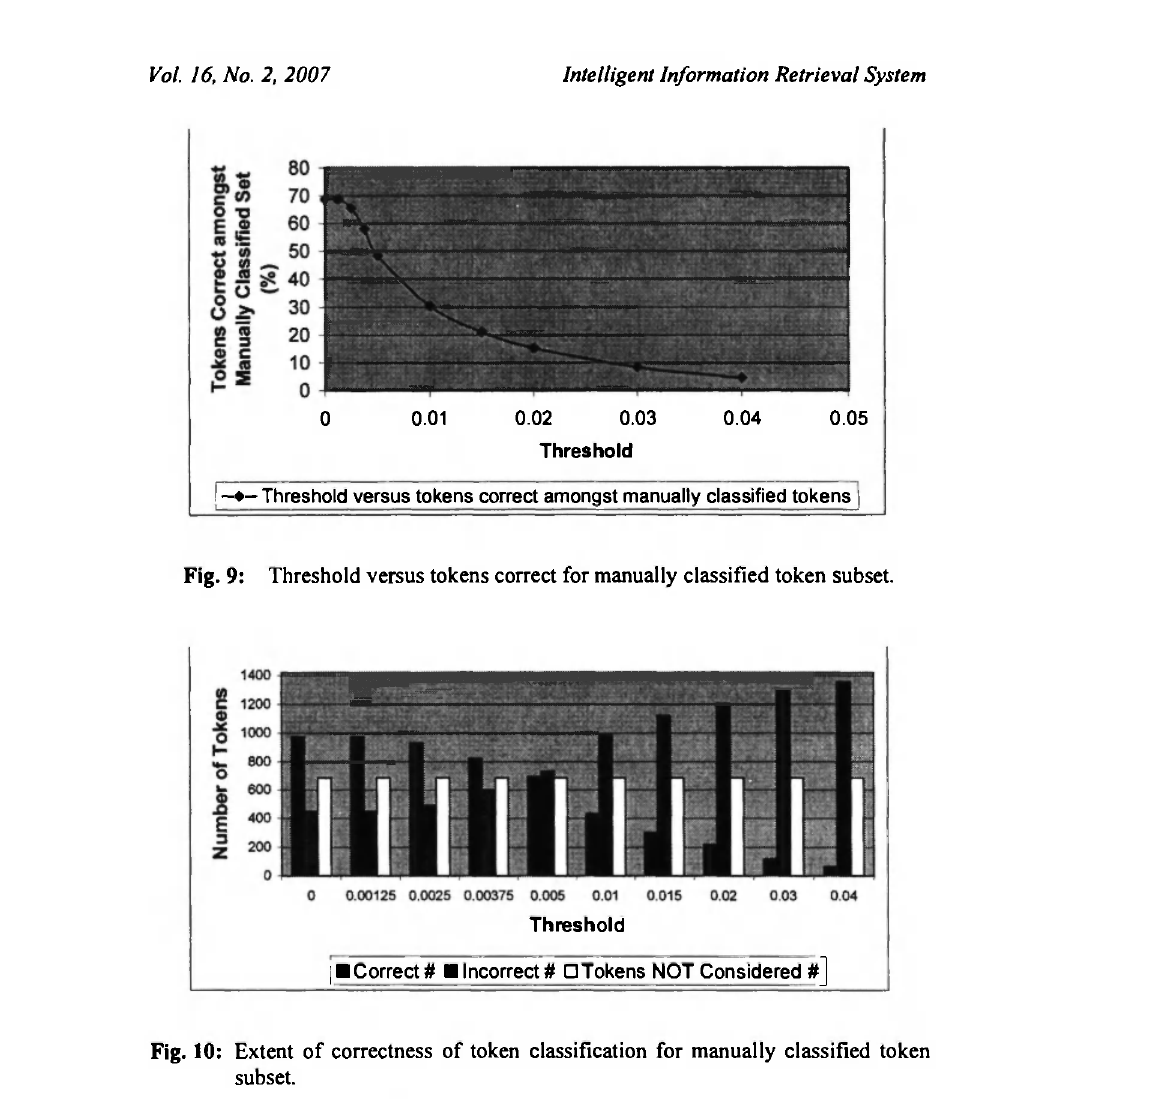
Fig. 10: Extent of correctness of token classification for manually classified token